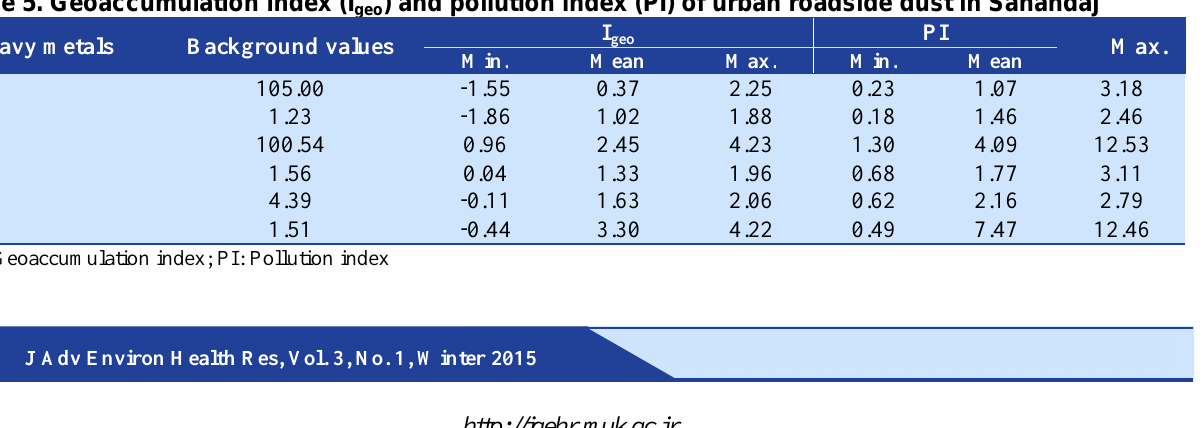
) and pollution index (PI) of urban roadside dust in Sanandaj geo